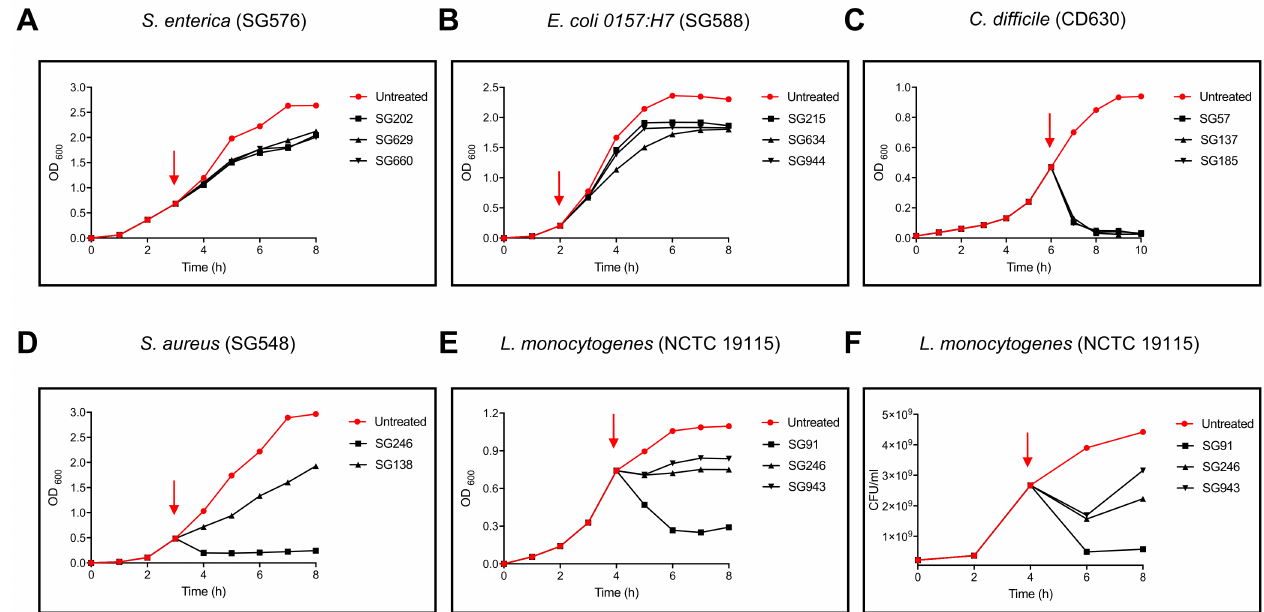
Figure 1. Pathogen growth kinetics in the presence of active components. Cell-free supernatants from Bacillus strain cultures (SGx) were added (1:10 v / v , indicated by red arrow) to mid-logarithmic cultures of Gram-negative and Gram-positive pathogens ( A – F ). ( A ) SG202, SG629 and SG660 supernatant was added (at time indicated by red arrow) to S. enterica (SG576); ( B ) SG215, SG634 and SG944 supernatant was added (at time indicated by red arrow) to E. coli 0157:H7 (SG588), ( C ) SG57, SG137 and SG185 supernatant was added (at time indicated by red arrow) to C. difficile (CD630); ( D ) SG246 and SG138 supernatant was added (at time indicated by red arrow) to S. aureus (SG548); ( E ) SG91, SG246 and SG943 supernatant was added (at time indicated by red arrow) to L. monocytogenes (NCTC 19115); ( F ) SG91, SG246 and SG943 supernatant was added (at time indicated by red arrow) to L. monocytogenes (NCTC 19115). Growth (OD 600 ) was monitored in cultures with or without (untreated) addition of supernatants. For L. monocytogenes growth by OD 600 and by determination of